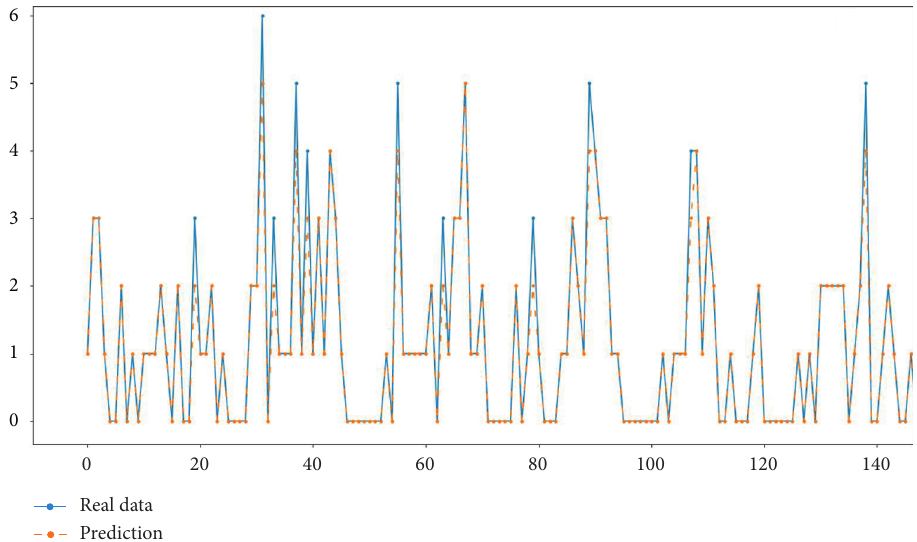
Figure 6: Comparison of the predicted value and the real value for CNN-LSTM.